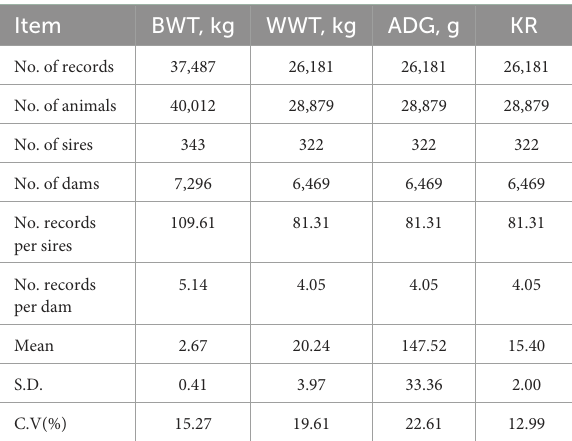
TABLE 1 Characteristics of the data structure for early growth traits of